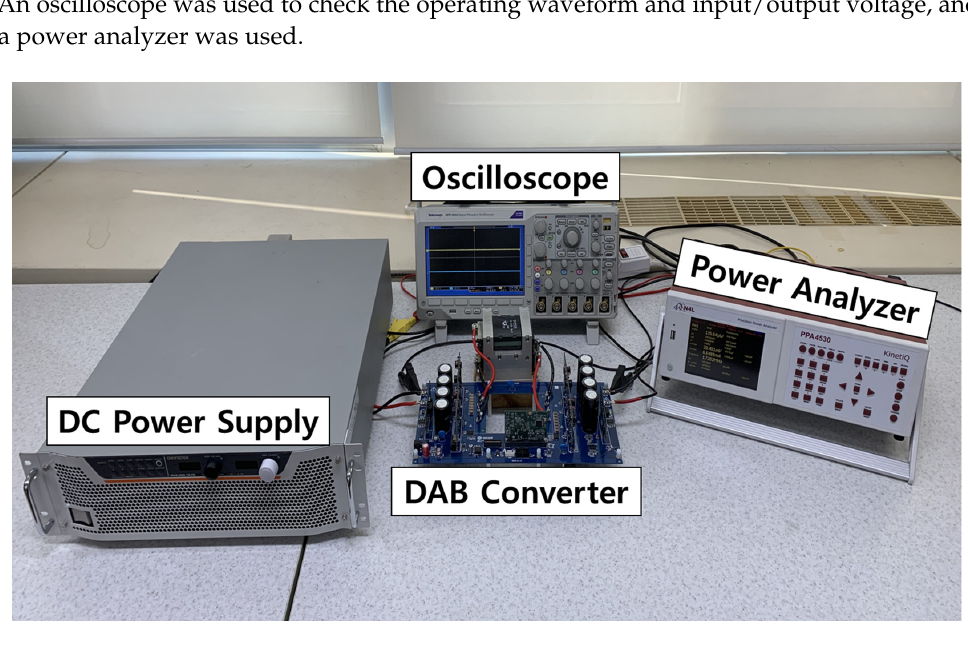
Figure 9. DAB converter experimental